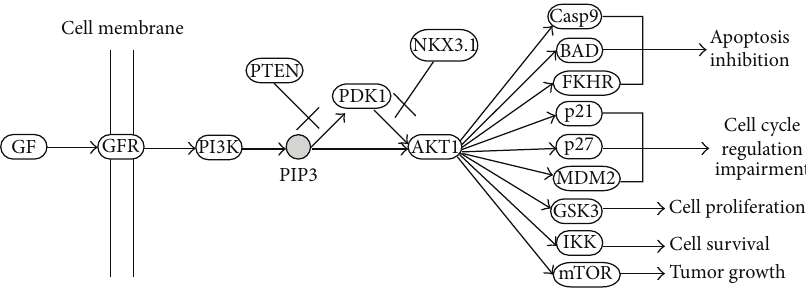
Figure 1: Regulation of AKT signalling